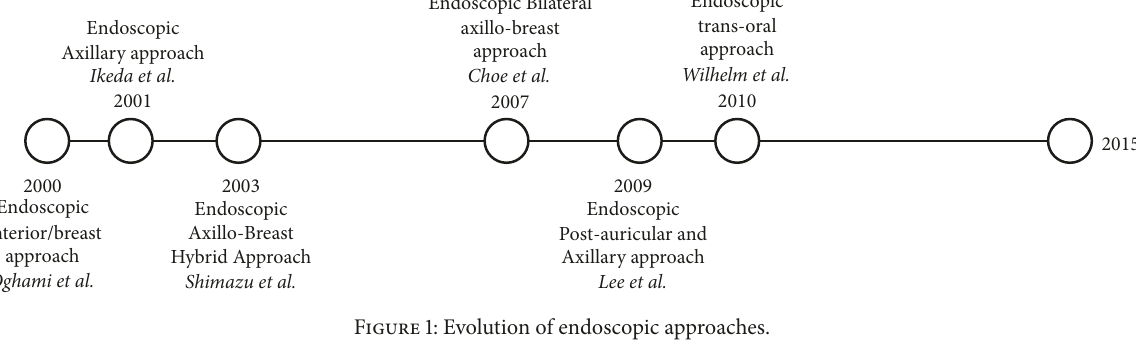
Figure 1: Evolution of endoscopic approaches.